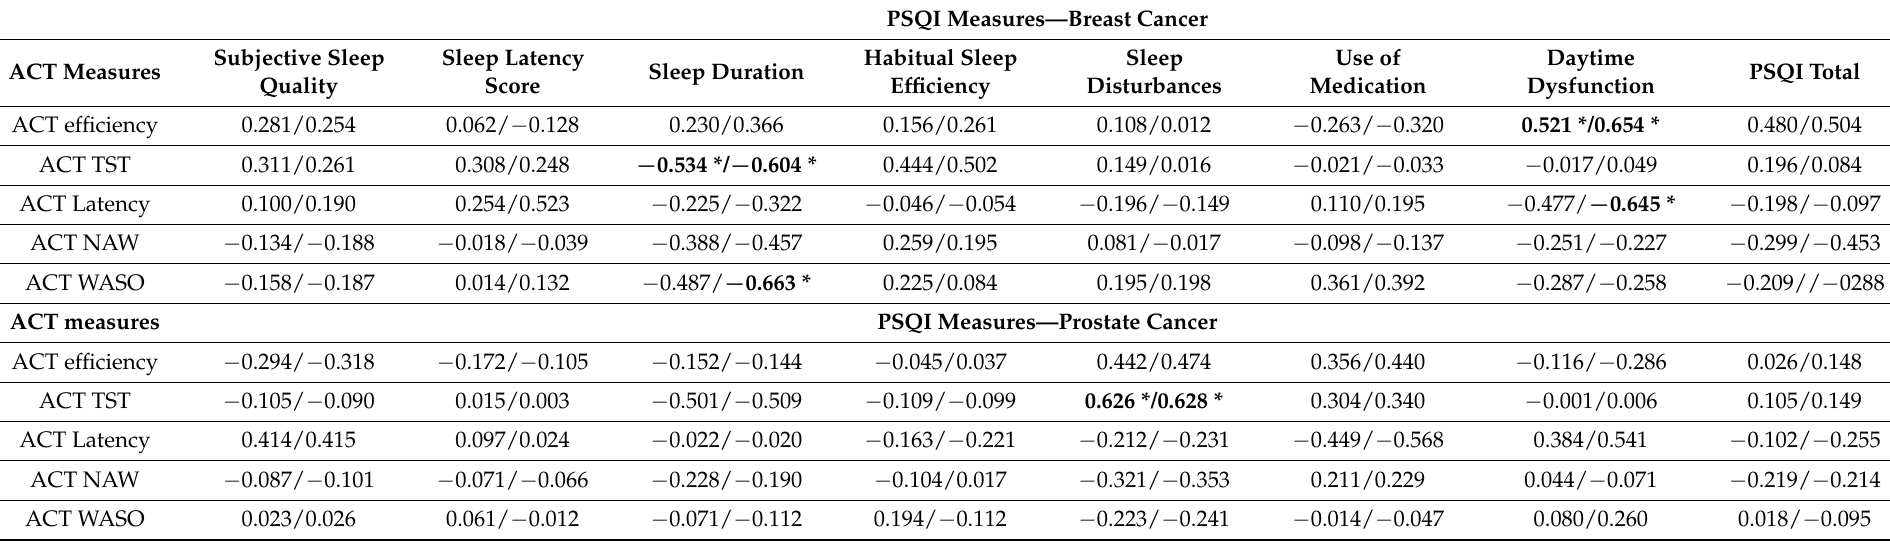
Table 3. Correlations of PSQI measures with ACT measures in breast cancer and prostate